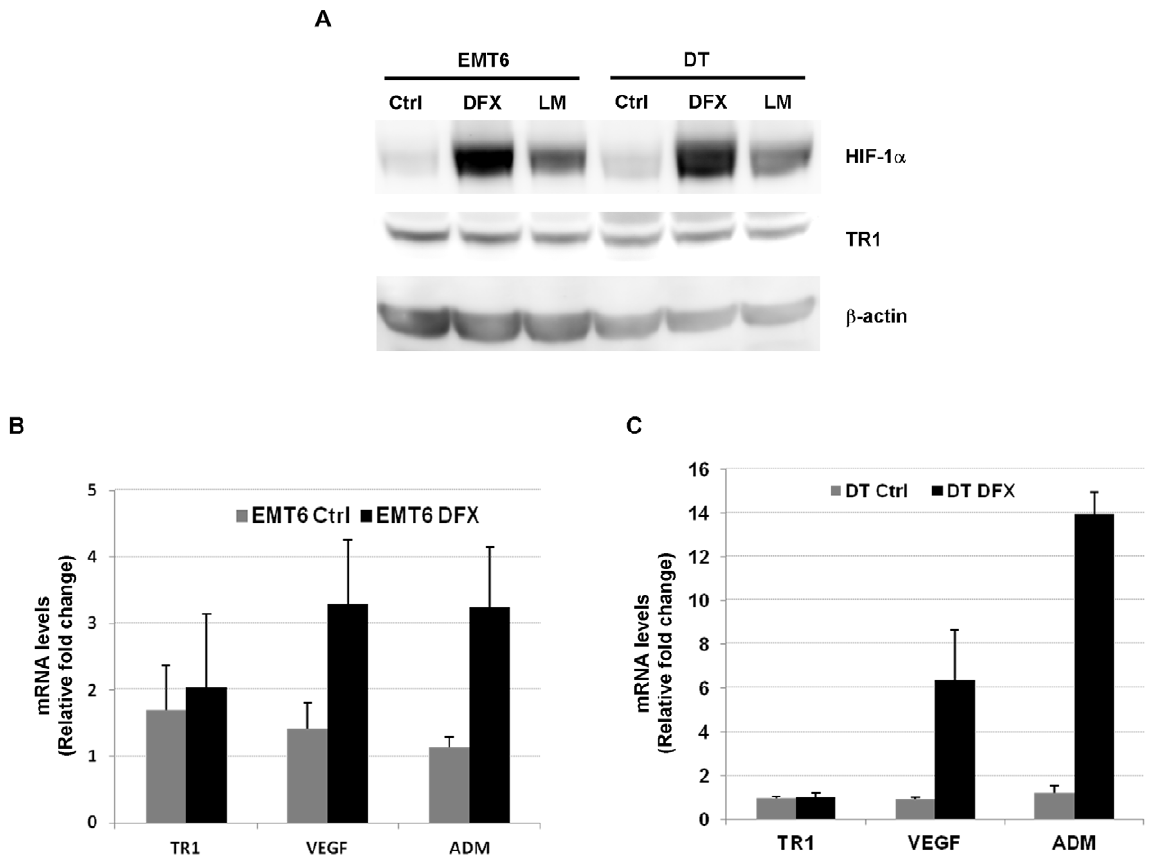
Figure 2. Effect of HIF-1 a stabilization by EGLN inhibitors on TR1 expression. (A) EMT6 and DT cells were treated with 150 m M of deferoxamine (DFX), 100 m M of L-mimosine (LM) or left untreated (Ctrl) for 12 h and the levels of HIF-1 a and TR1 protein detected by western blotting. The mRNA levels of TR1, VEGF and ADM from (B) EMT6 cells and (C) DT cells, treated with deferoxamine (DFX) or left untreated (Ctrl) for 8 h, were measured by quantitative RT-PCR. The data represent the fold-change relative to untreated cells after normalization with the b -actin content. The mean and 6 SE of 3 independent experiments is shown.